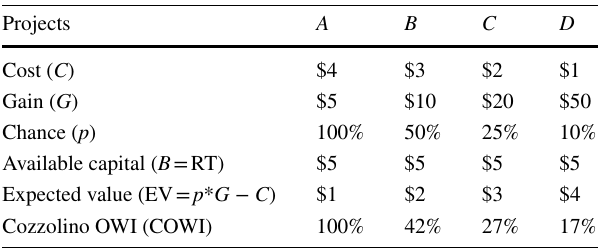
Table 1 Four projects evaluated using the Cozzolino method. OWI refers to the optimum working interest one should take in a project using (Eq. 9) of Appendix Projects